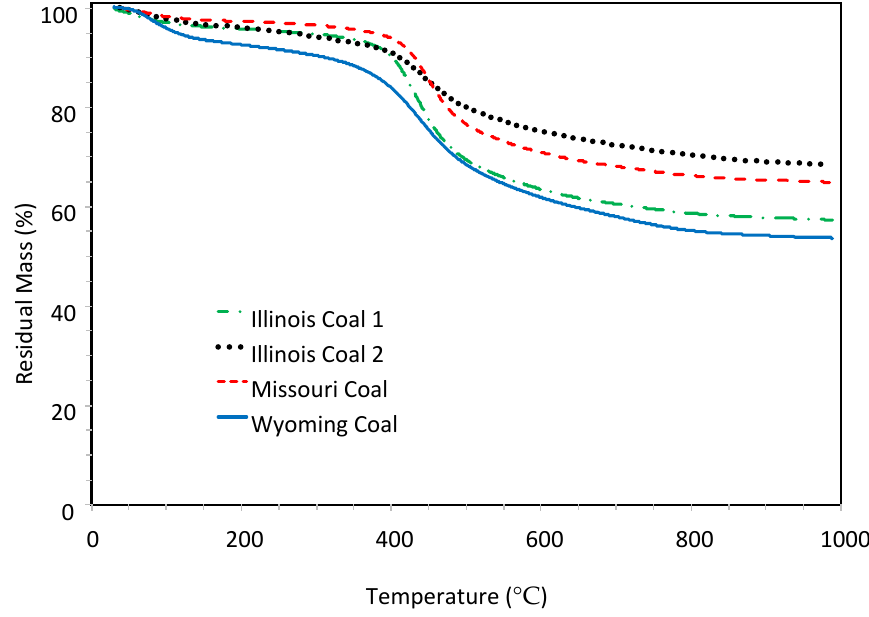
Figure 3. TGA of coal specimens pyrolyzed under nitrogen. The two Illinois coal samples were from different batches. All specimens were pulverized. The heating rate was 10 °C min −1 .